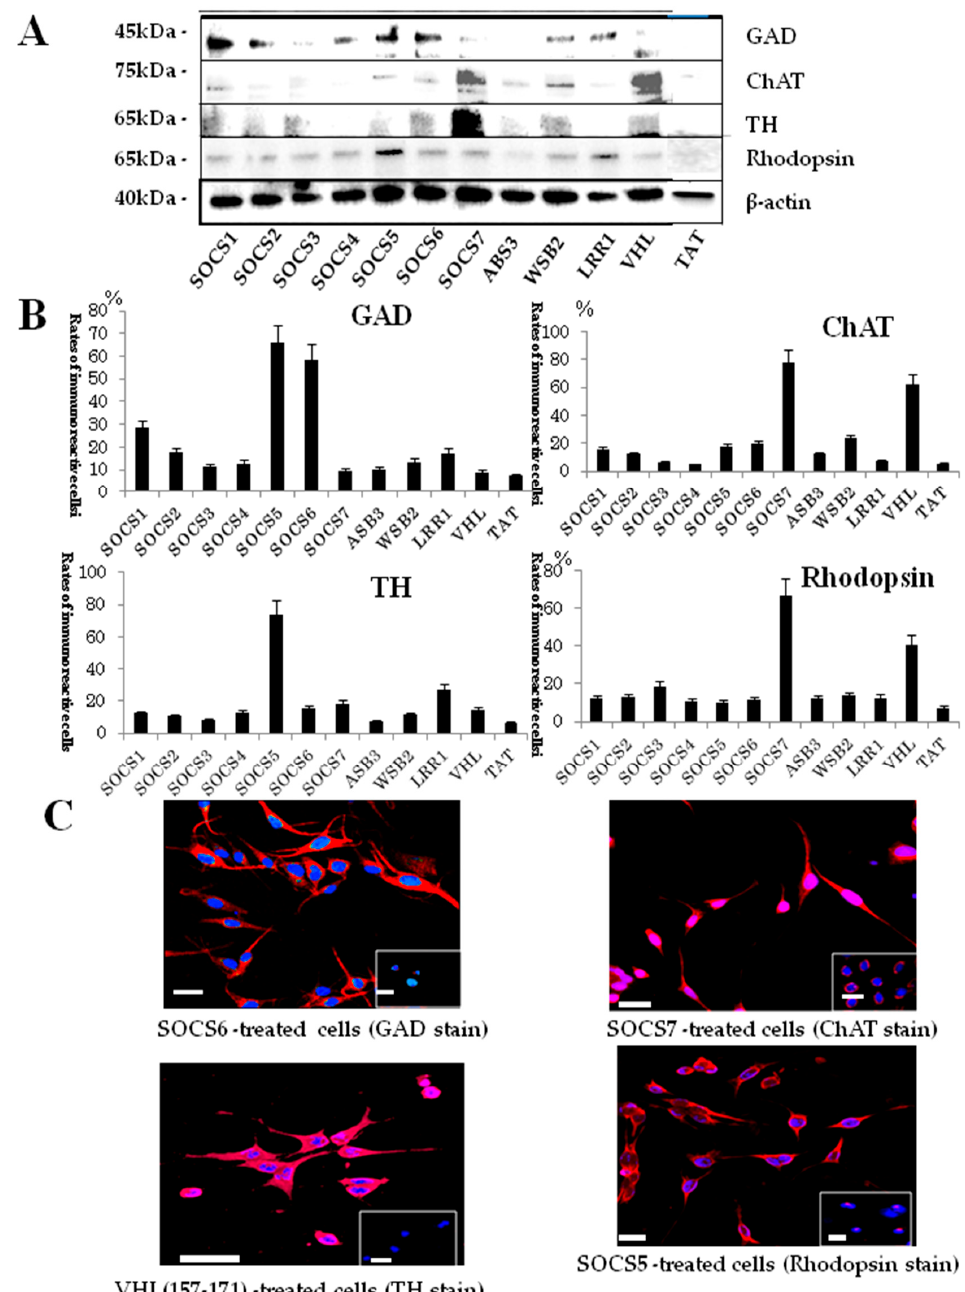
Figure 6. ( A ) Western blotting analyses of cells delivered neuronal-differentiation-domain (NDD) peptides for glutaminc acid decarboxylase (GAD), choline acetyltransferase (ChAT), tyrosine hydroxylase (TH), and rhodopsin; ( B ) Rates of immunoreactive cells treated by NDD peptides for ChAT, rhodopsin, TH, and GAD; ( C ) Characteristic immunocytochemical images of cells treated by NDD peptides for GAD, ChAT, TH, and rhodopsin. Upper left, SOCS6 peptide-treated cells stained by GAD. Upper right, SOCS7 peptide-treated cells stained by ChAT. Lower left, VHL(157–171) peptide-treated cells stained by TH. Lower right, SOCS5 peptide-treated cells stained by rhodopsin. GAD, ChAT, TH, and rhodopsin, expressions are indicated by TRIC (red). Nuclei, DAPI (blue). Small panels at lower right corners in all panels show images of negative control cells. Scale bars = 20 μ m.